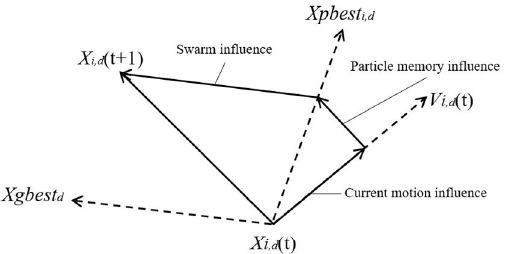
Figure 1. Update process of particle position in multidimensional space